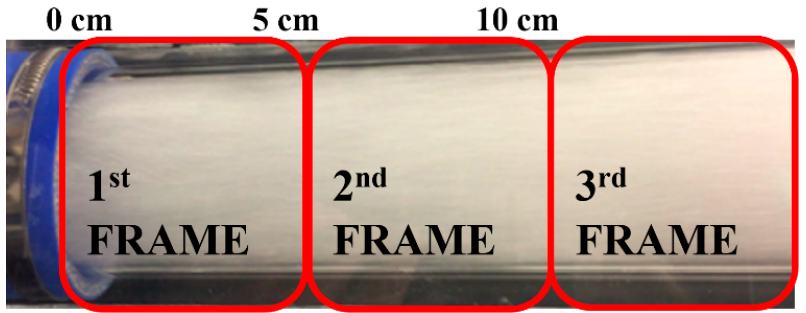
Figure 4. Recorded images positioning along the flow (front view).